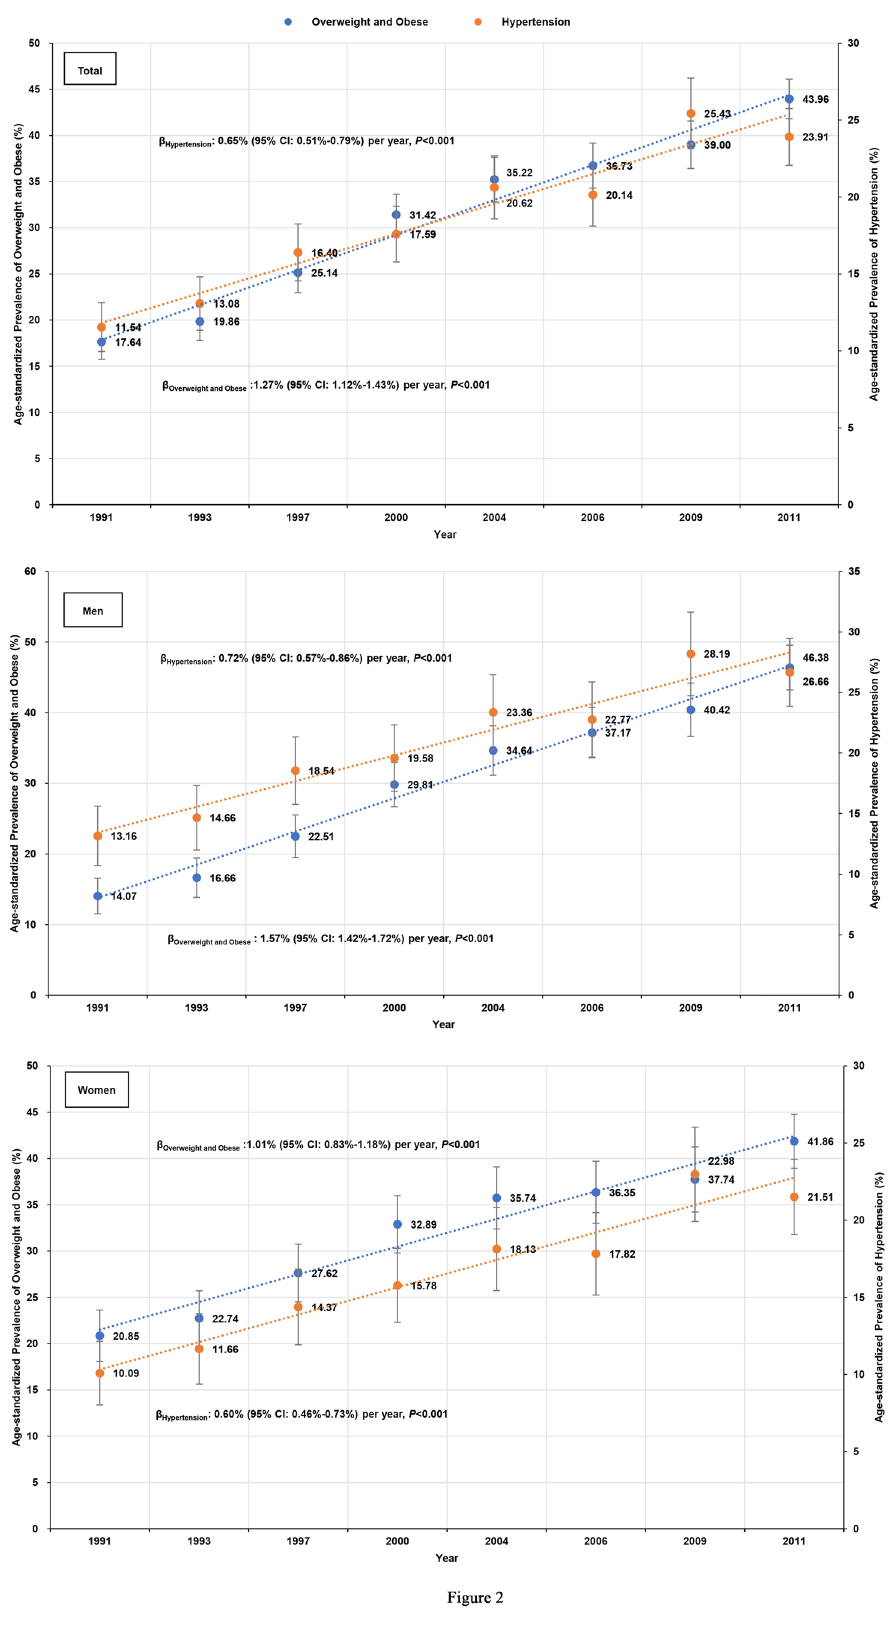
Figure 2. Secular trends in age-standardized prevalence of hypertension (95% CIs) and age-standardized prevalence of